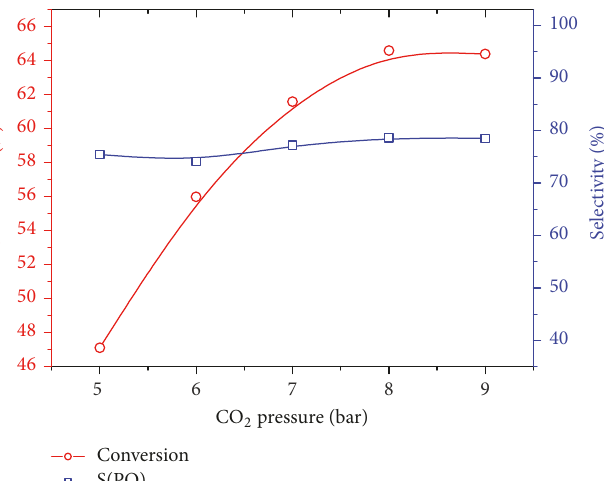
Figure 8: Effect of CO 2 pressure on conversion and PO selectivity. Reactions catalyzed by 0.150 g of catalyst and 0.050 g of TEABr (cocatalyst) at 65 ∘ C during a period of 7